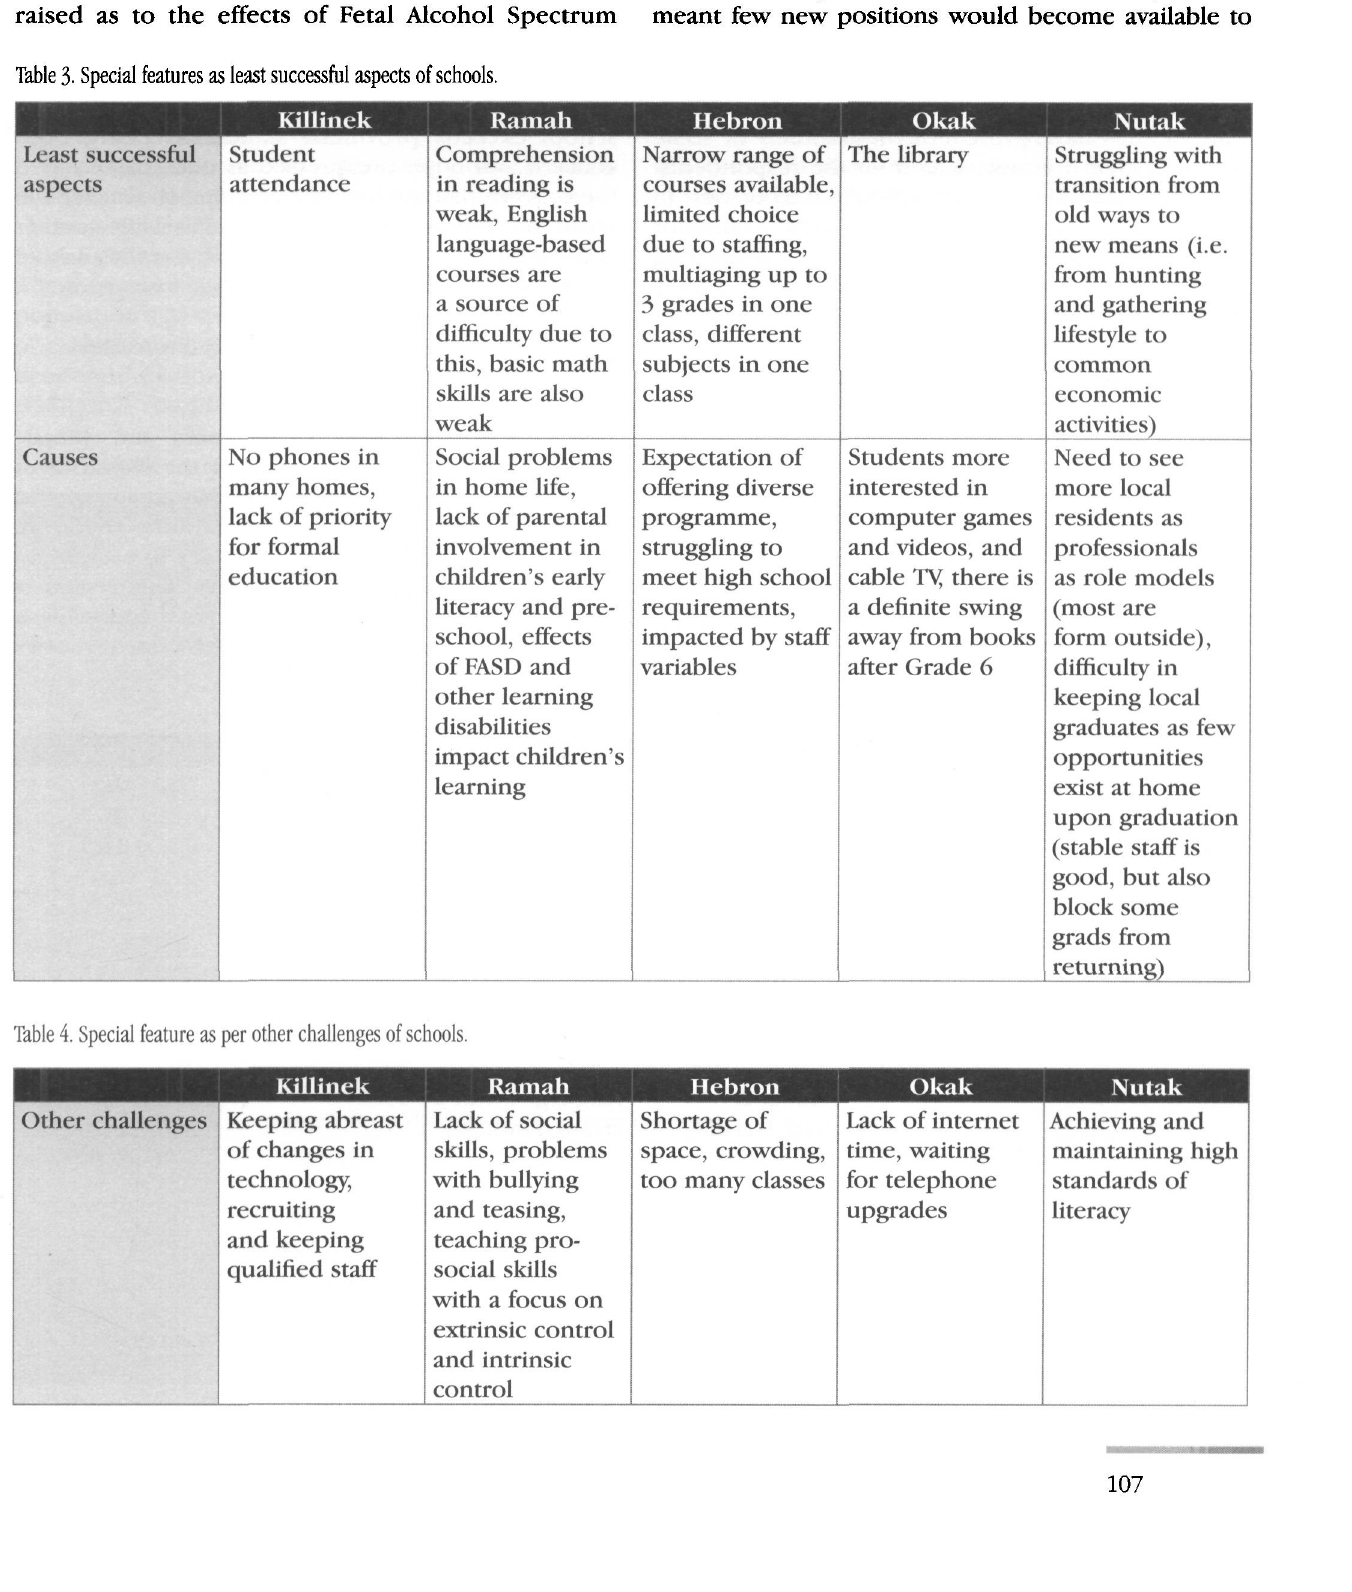
Table 4. Special feature as per other challenges of